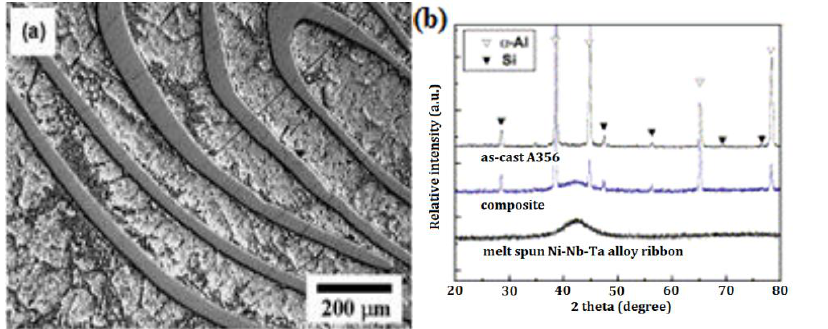
Figure 1. ( a ) Optical micrographs of Ni-Nb-Ta metallic glass ribbon reinforced A356 alloy based composite; ( b ) X-ray diffractograms of Ni-Nb-Ta metallic glass ribbon reinforced